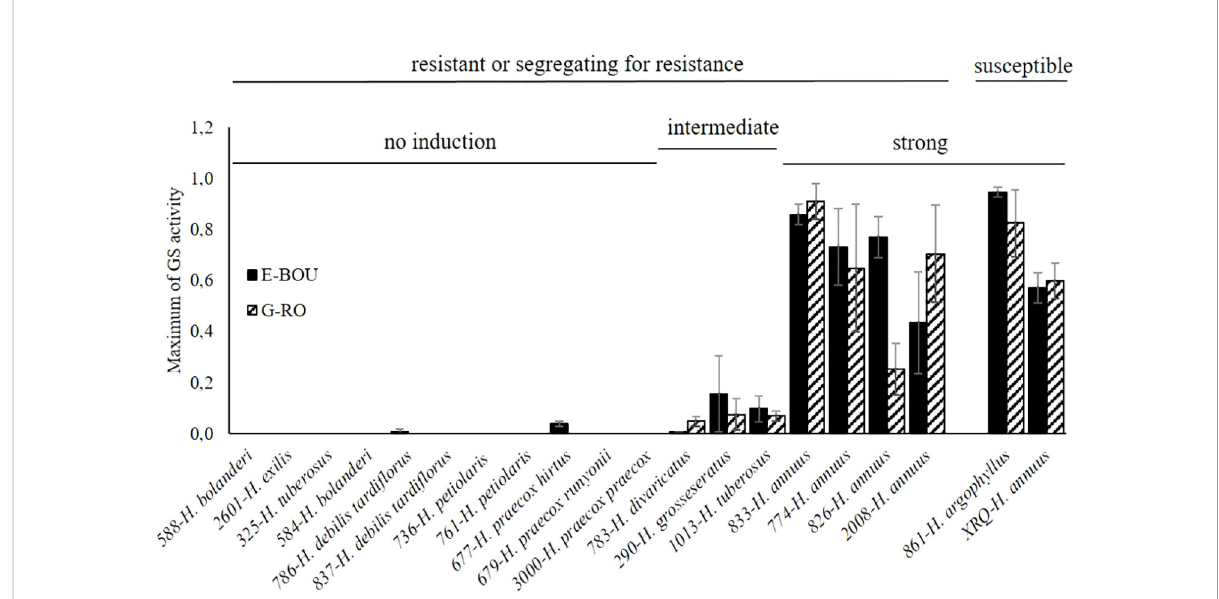
FIGURE 3 Root exudate activity of various Helianthus species on seed germination of two O. cumana populations. Maximum of germination stimulant activity of root exudates of 18 Helianthus accessions, 1 susceptible H. argophyllus and the susceptible control XRQ, on the seeds of the two O. cumana populations, E-BOU and G-RO (bar: ± SE), were determined from the time-response curves presented in the Supplementary File 7. The average activity of root exudates of the most active week was used for the Figure